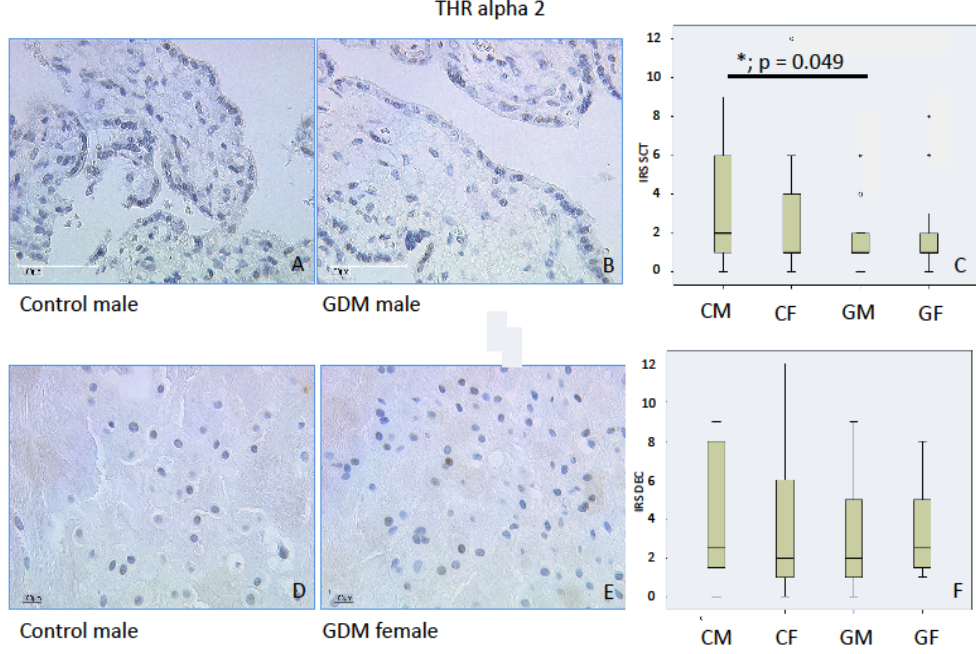
Figure 2. THR α 2 immunoreactivity is found with low intensity in control SCT ( A ) and in control decidua ( D ). In SCT, we found a significantly weaker immunolabelling intensity for male GDM ( A , B ). In the decidua, we could not identify a significant difference ( D , E ). IRS for each group are shown as box plots for SCT (IRS SCT) ( C ) and the decidua (IRS DEC) ( F ). The boxes represent the range between the 25th and 75th percentiles with a horizontal line at the median. The circles indicate values more than one and a half box lengths, and the asterisk values more than three box lengths from the 75th percentile. Groups are labelled as follows: CM = control male; CF = control female; GM = GDM male; GF = GDM female. Scale bar = 100 µm.